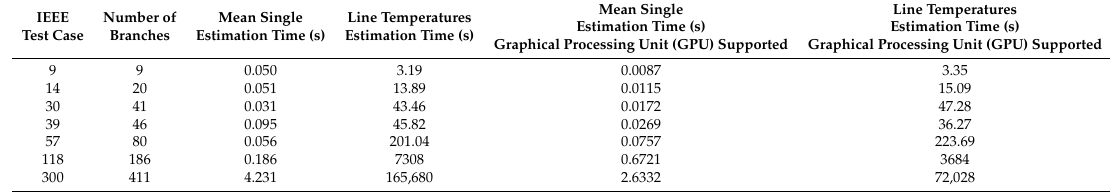
Table 1. Time of the two-step algorithm realization depending on the power system size.